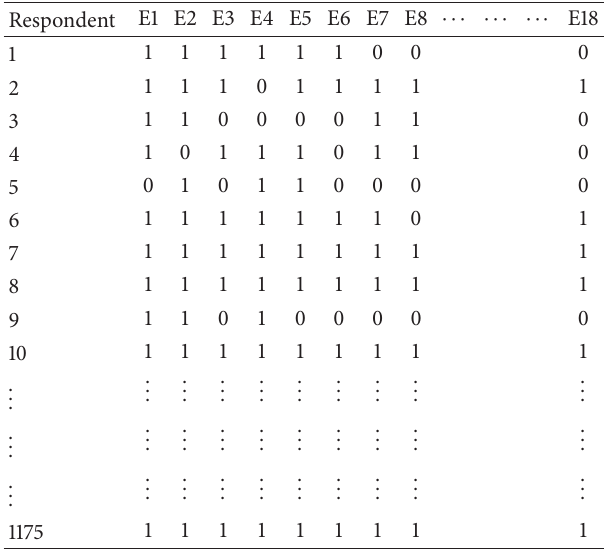
Table 1: Study variables and descriptions. Table 2: The data